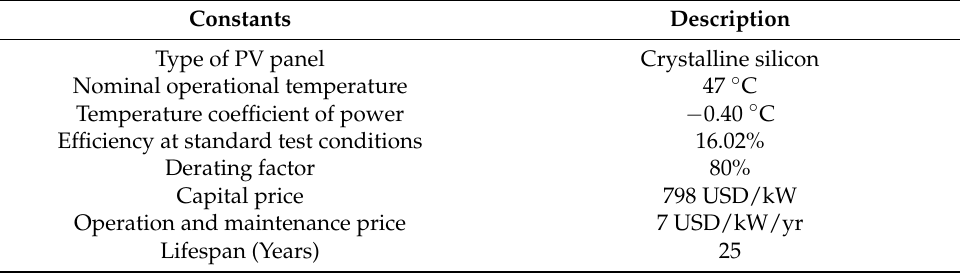
Table 2. Cost and technical data of the PV panel.